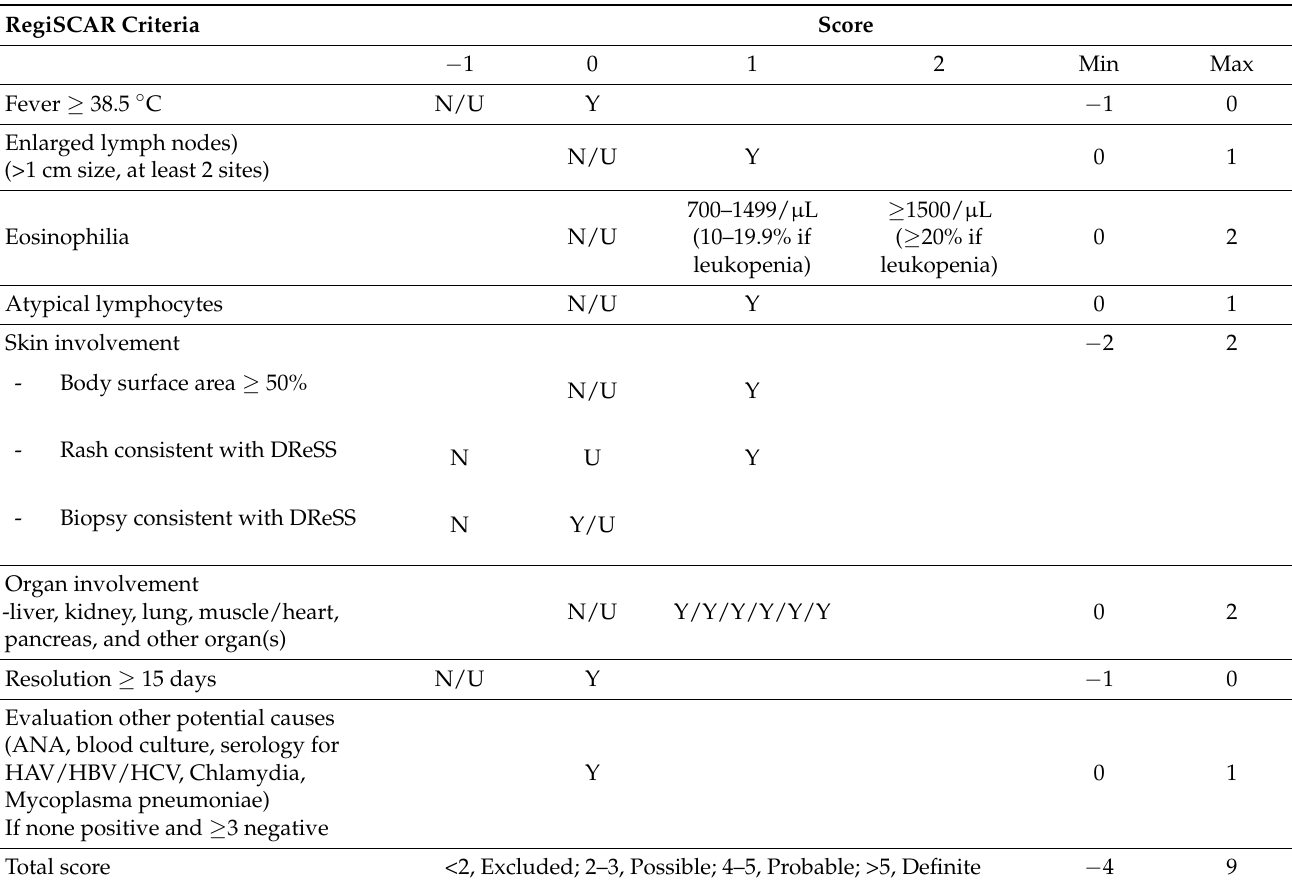
Table 4. RegiSCAR validation score for DReSS syndrome